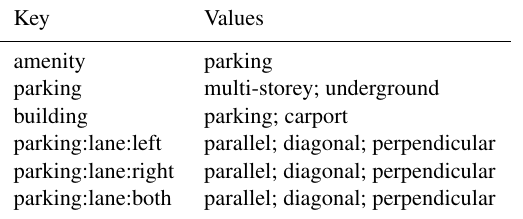
Table A2. Keys and values for parking